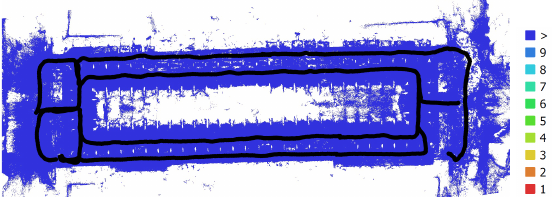
Figure 16. Planar visualization of camera locations and tie points, showing also the large multiplicity (>9) of the matched point used for image orientation.